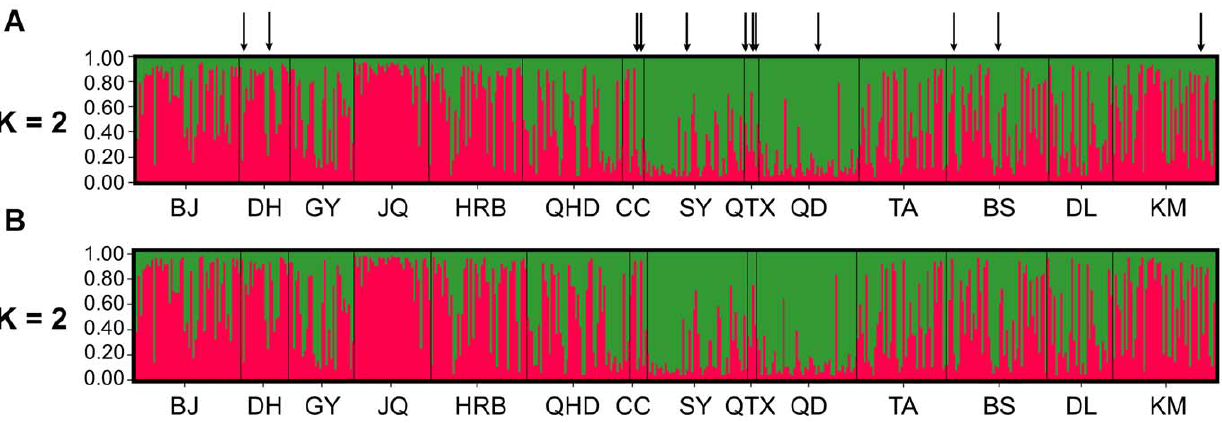
Figure 2. Bayesian clustering analysis using STRUCTURE indicating the presence of two clusters. Each individual is represented by a vertical bar displaying membership coefficients to each genetic cluster. (A) Analysis based on the whole datasets, the arrows point to the 12 WFTL individuals. (B) Analysis based only on WFTG individuals.